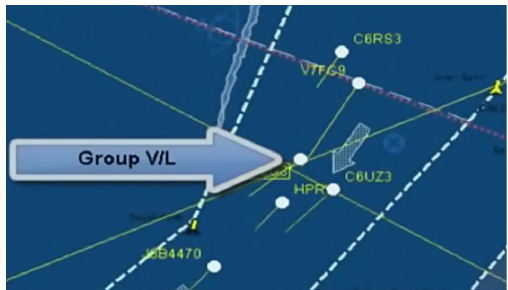
Figure 1. Observed vessel before starting turning to starboard